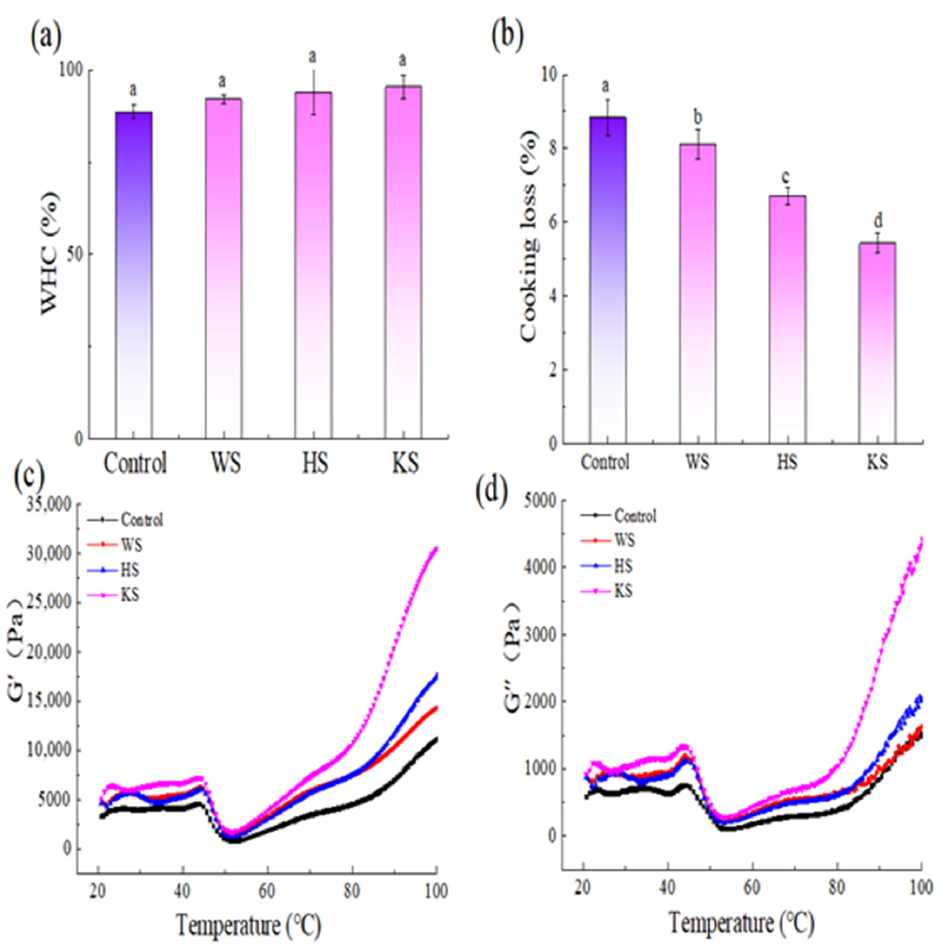
Figure 1. Gel properties ( a , b ) and rheological properties ( c , d ) of silver carp surimi with different treatments. Control: Surimi (75%) + water (25%); WS: Surimi (75%) + wakame slurry (25%); HS: Surimi (75%) + hijiki slurry (25%); KS: Surimi (75%) + kelp slurry (25%). Values are expressed as the means ± SD and results are representative of at least three independent experiments. a–d indicates that the different letters are significantly different ( p <